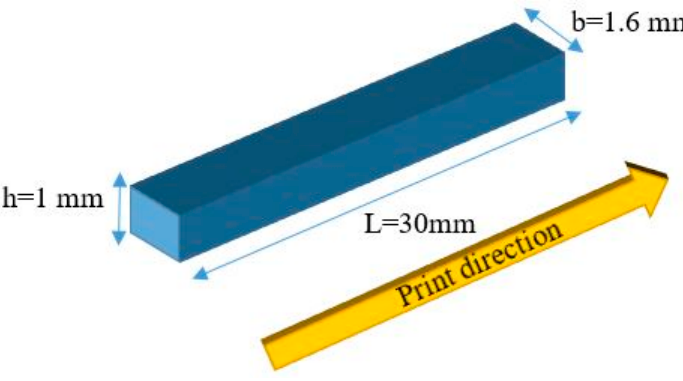
Figure 4. Geometry of the 3D-printed sample.